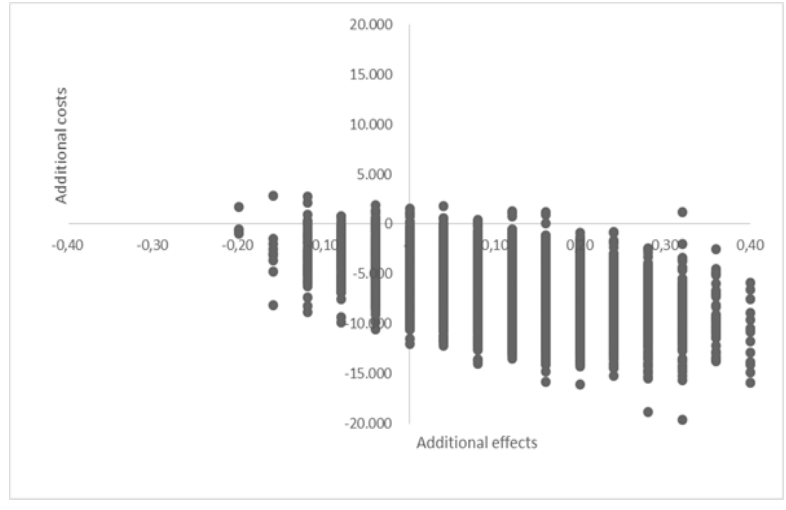
Figure 1. Cost-effectiveness plane of bootstrap results ( n = 5000). Figure 1. Cost-e ff ectiveness plane of bootstrap results ( n =